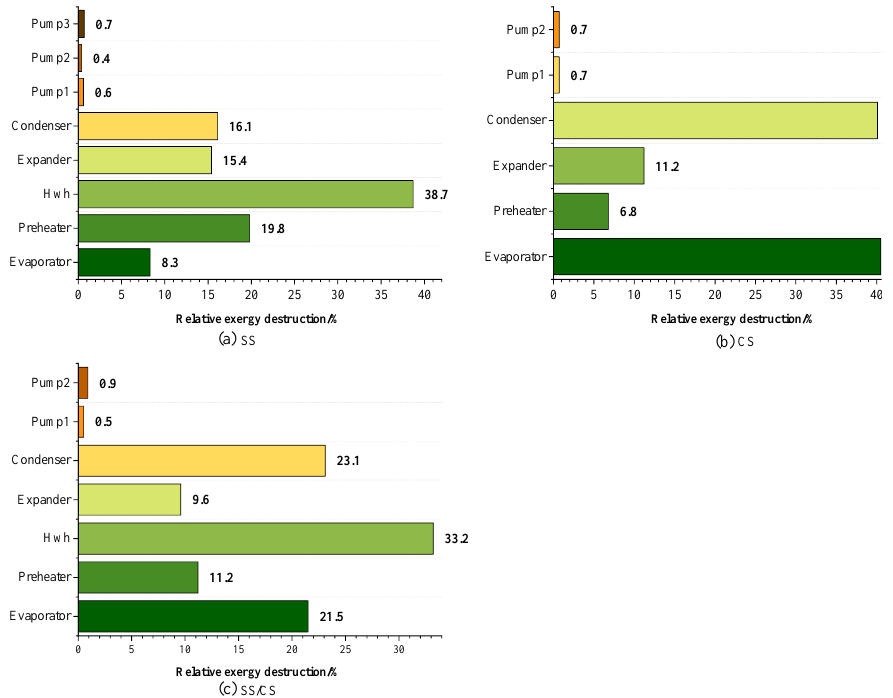
Figure 13. Contribution of components in the total exergy destruction rate: (a) SS and (b) CS and (c) SS/CS.